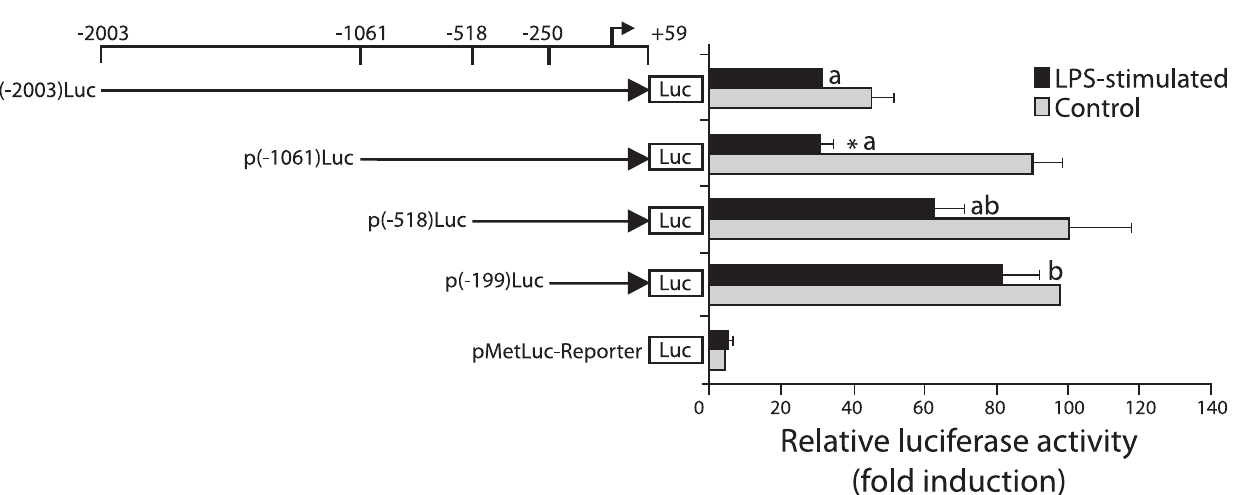
Figure 3. Structural and functional analysis of the 5 9 -upstream region of the salmon Eomes gene. HeLa cells were transiently transfected with 0.3 m g of Eomes promoter/luciferase plasmid and 0.1 m g of Eomes promoter/SEAP plasmid (internal control). HeLa cells were stimulated with LPS and after 24 h luciferase activities were measured. Units of luciferase activity were normalized to activity of cotransfected pSEAP (relative luciferase activity). The error bars represent S.E.M values (n=3). Asterisk (*) above the bars shows significant difference ( P , 0.05) compared to respective control and the different letters (a and b) on the bars denote significant difference compared to the smallest construct. The bent arrow represents the salmon Eomes transcriptional start site.